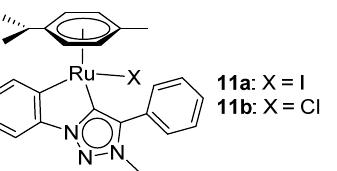
Figure 2. Poorly active and inactive CC -orthometalated triazolylidene Ru(II) complexes 11a and 11b .